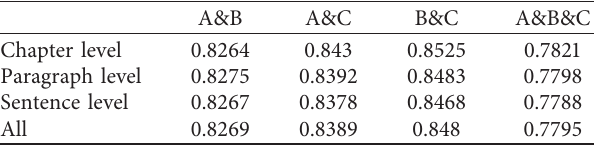
Table 1: Statistics of the coincidence rate of the labeling